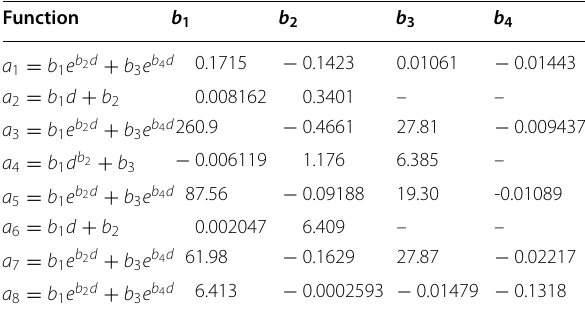
Table 1 Fit coefficients for the shadow factor